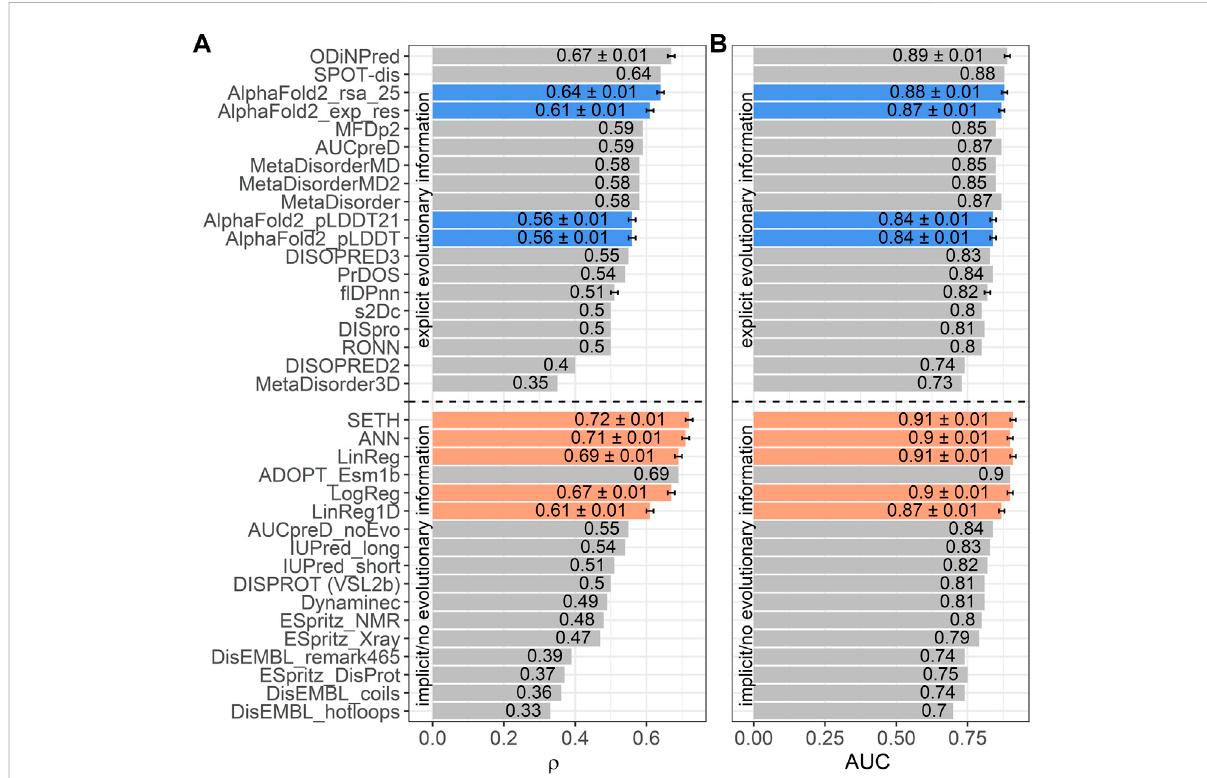
FIGURE 3 Data: set CheZOD117 (Dass et al., 2020). Performances of all methods introduced here (SETH, ANN, LinReg, LogReg, LinReg1D) in orange, the ODiNPred web application in grey (Dass et al., 2020), ADOPT ESM-1b in grey (Redl et al., 2022), the fIDPnn server in grey (Hu et al., 2021) and four disorder measures derived from AlphaFold2 (Jumper et al., 2021) in blue [these are: AlphaFold2_ pLDDT , AlphaFold2_pLDDT21: smoothed over 21- consecutive residues (Akdel et al., 2021), AlphaFold2_exp_res: experimentally resolved prediction, AlphaFold2_rsa_25: running average over relative solvent accessibility averaged over 25 consecutive residues (Piovesan et al., 2022)]. All other performances were taken from the previous comparison (Nielsen and Mulder, 2019) using the same test set (see Methods Evaluation ). While three of our models (SETH, ANN, LinReg/LinReg1D), ADOPTESM-1bandODiNPredweretrainedoncontinuouschemicalshiftZ-scores(CheZODscores),thelogisticregression,LogReg,wastrainedon abinary classi fi cation of order/disorder (CheZOD score > 8/ ≤ 8). ODiNPred and ADOPT ESM-1bused more proteinsfor training than our models. The horizontal dotted line separates models using MSAs (above line) from single sequence-based methods (below line). Error bars mark the 95% con fi dence interval, approximated by bootstrapping for our methods, AlphaFold2 , the ODiNPred web application and the fl DPnn server (Methods). Panel (A): Performance measured with the spearman correlation coef fi cient ( ρ ; Eq. 2) between the ground truth and the prediction. Panel (B): Performance measured with the area under the receiver operating characteristic curve (AUC; Eq. 3) after the binary projection of the ground truth CheZOD scores [order: CheZOD score > 8, disorder: CheZOD score ≤ 8; (Nielsen and Mulder,